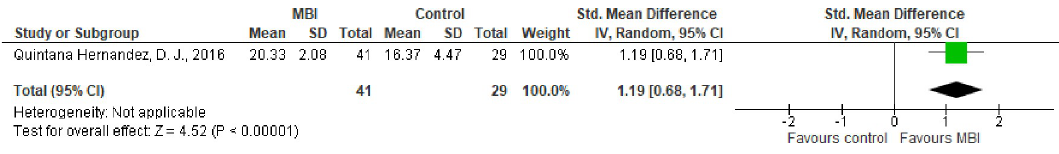
Fig 8. Forest plot of comparison: Cognitive function, MBI versus control after 11 weeks to 6 months from the beginning of the intervention.